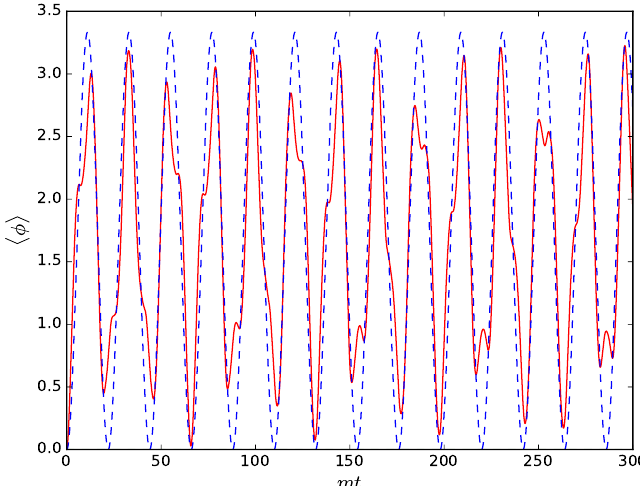
Figure 2 . Expectation value h (cid:30) i for the potential (3.1). The dashed blue line refers to the (cid:12)t with function 1 (1 (cid:0) cos((cid:1) Et )), with g = 0 : 3 and (cid:1) E = 0 : 285763, matching the matrix approximation 2 g